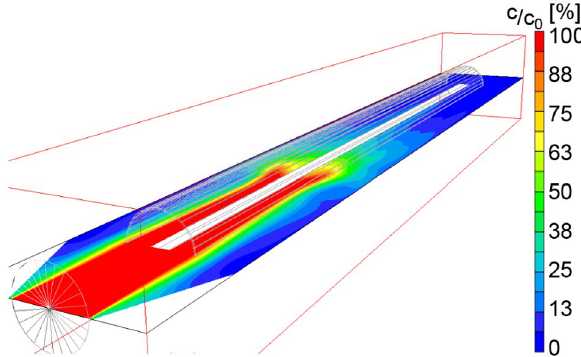
Fig. 2 CFD simulation result for prototype A. Displayed here is a x–z-section of the simulation space shown in Figure S3 of Online Resource 1. All concentrations are given as percentages relative to the uptake concentration Table 2 Analytically (NDR, degree of efficiency) and numerically (RDR, pressure drop) determined coefficients for all prototypes